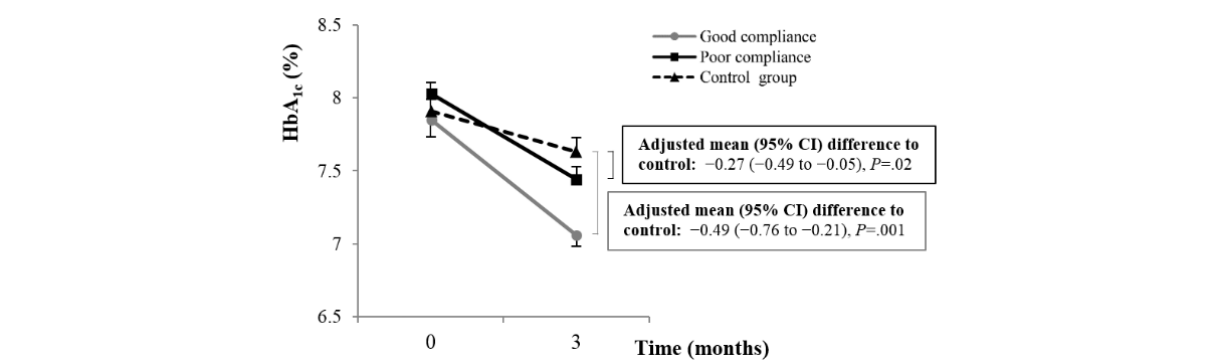
Figure 3. Changes in hemoglobin A 1c (HbA 1c ) according to the self-monitoring of blood glucose compliance of the intervention group compared with the control group. Data are expressed as mean (SE).